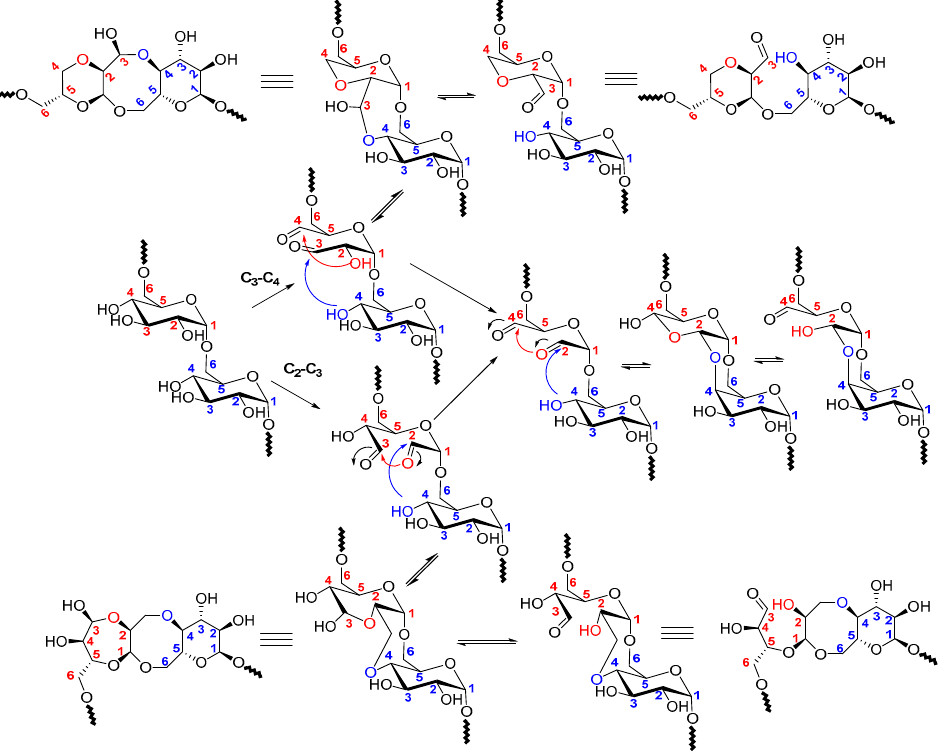
Figure 5. Formation of hemiacetal-type structures during oxidative cleavage of dextrans.